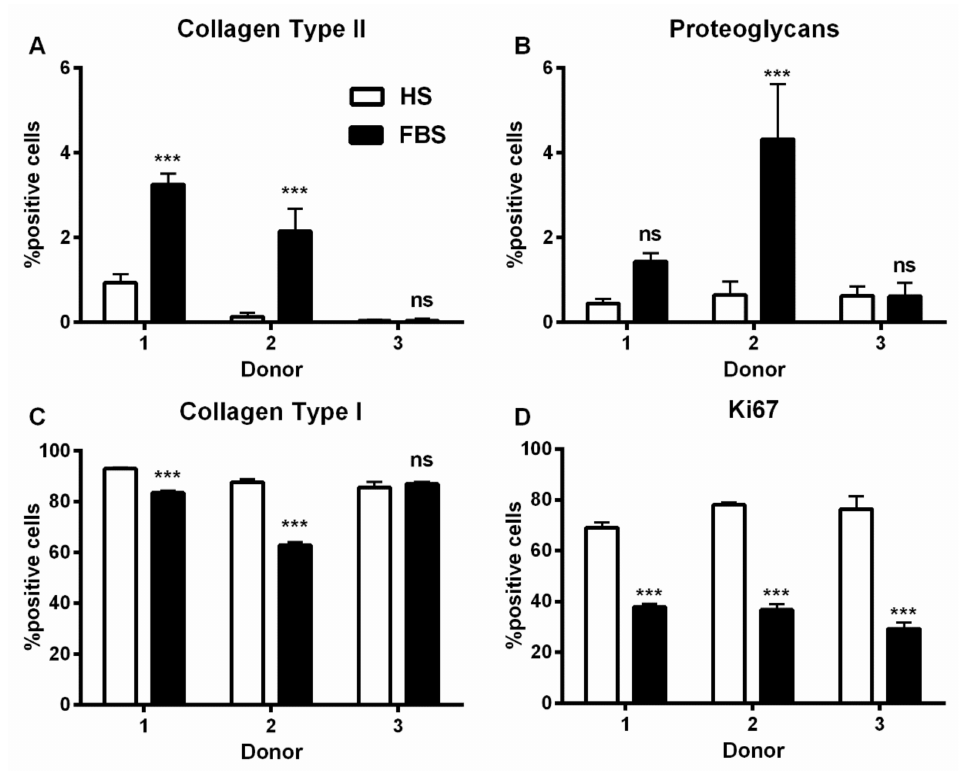
Figure 4. Percentage of chondrocytes expressing cartilage-specific matrix molecules. P2 chondrocytes were cultivated with the medium containing either HS or FBS. The expression of the cartilage-specific molecules collagen type II ( A ) and proteoglycans ( B ), the dedi ff erentiation marker collagen type I ( C ), and the proliferation marker Ki67 ( D ) were analyzed via indirect immunocytochemistry. (Not significant (ns), ***: p <